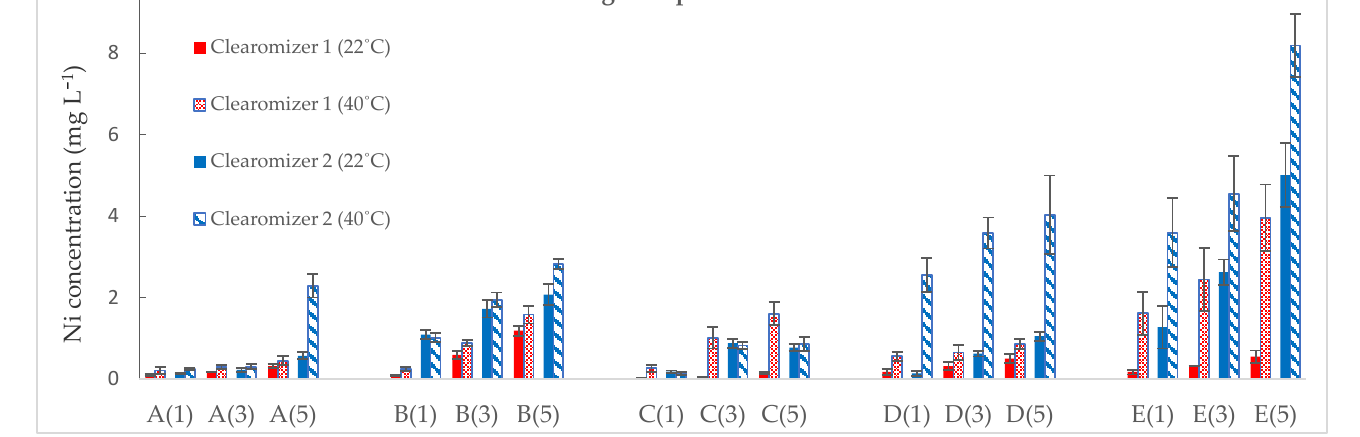
Figure 3. The influence of storage temperature and of the clearomizer on Ni concentration. Sample code: Sample number (number of storage days in the clearomizer).